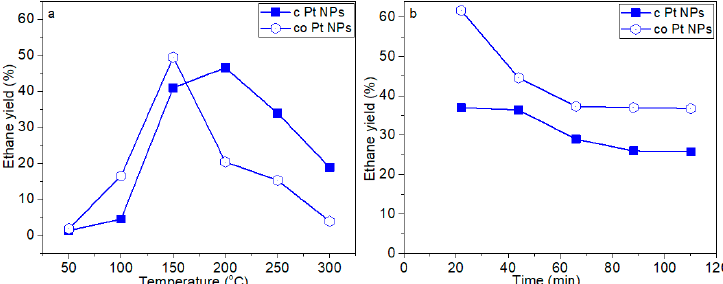
Figure 9. Catalytic HDCl of TCE on ZrO 2 supported cubic (c) and cuboctahedral (co) Pt NPs: ( a ) ethane yield vs. temperature; and ( b ) ethane yield vs. time at 150 °C.